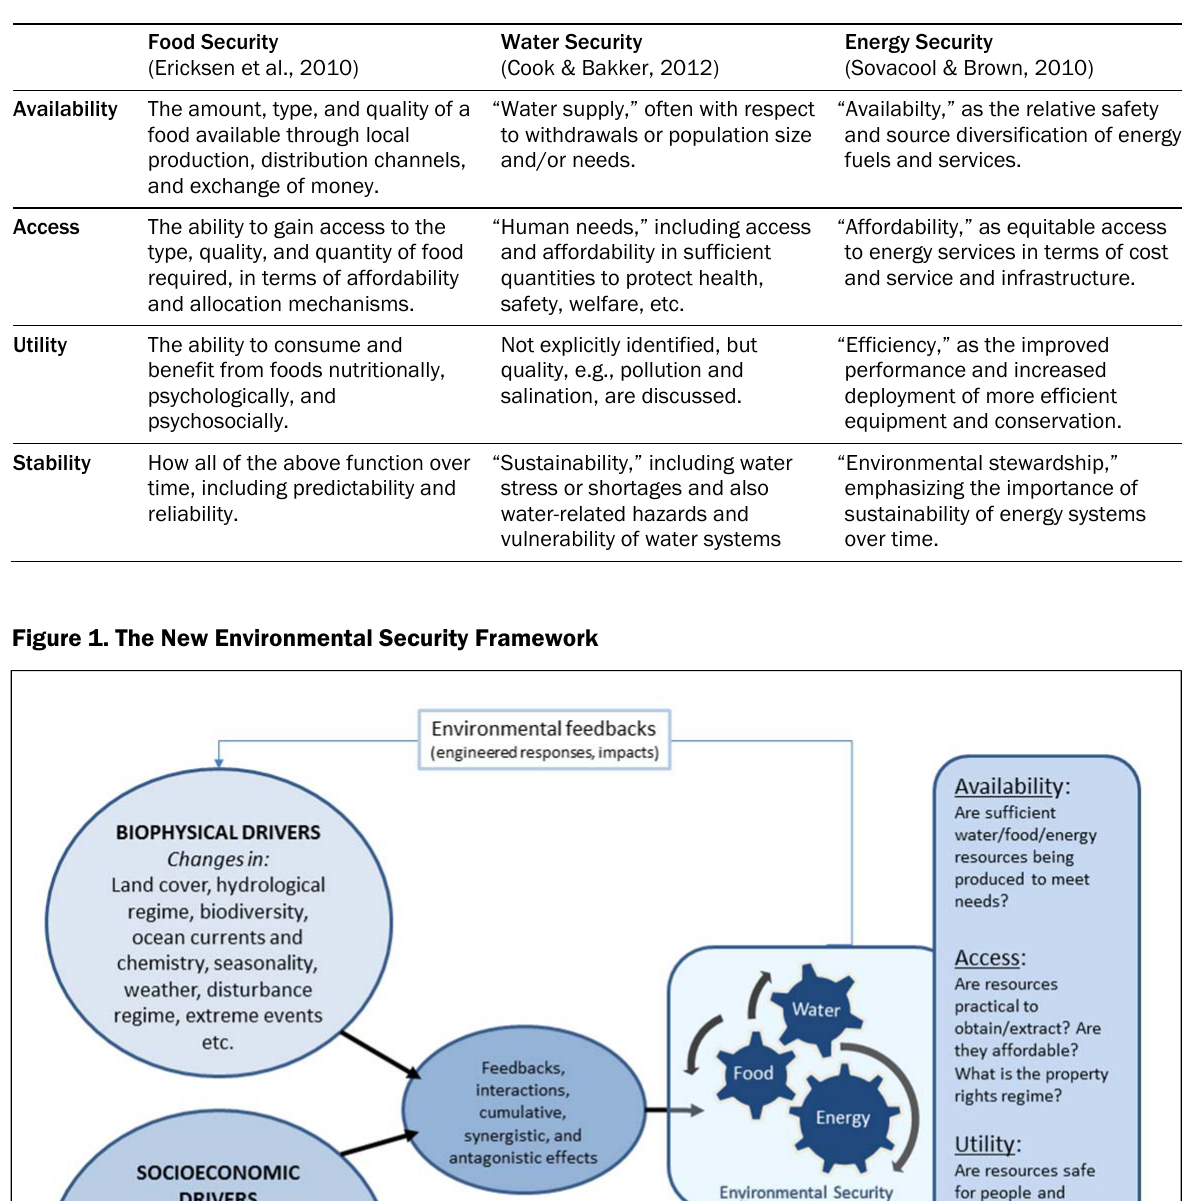
Table 1. The Four Components of Food Security and their Analogs in Water and Energy Security